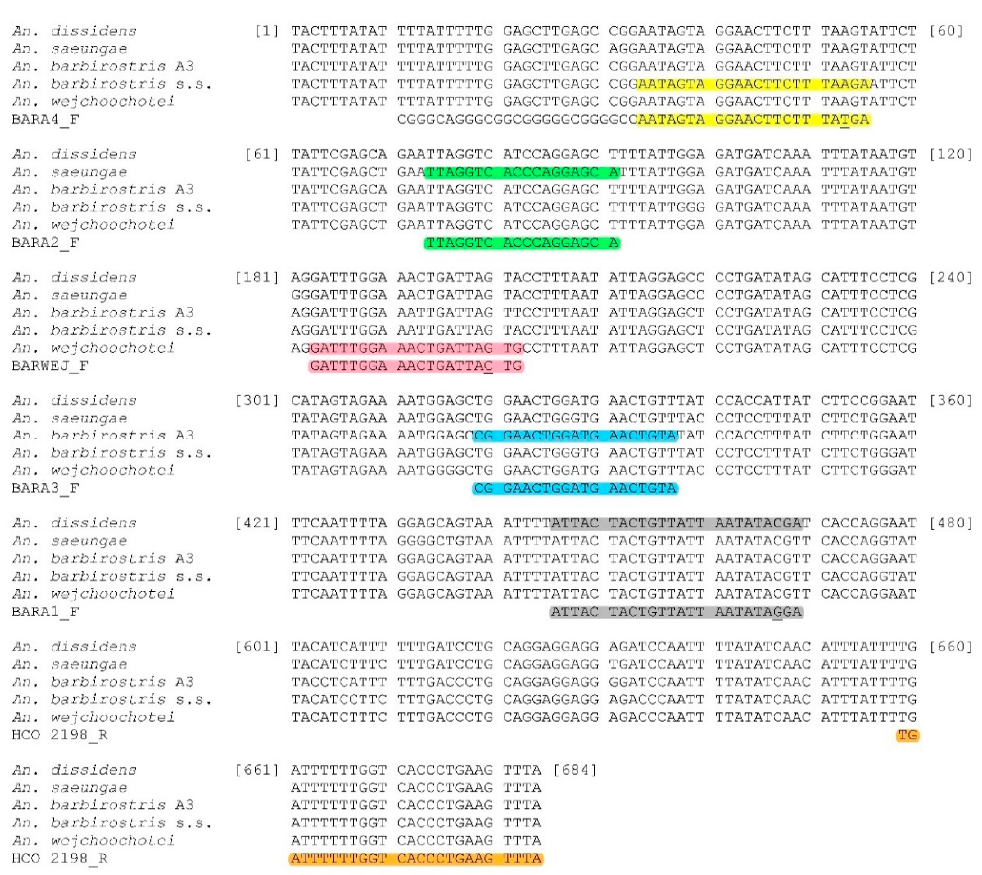
Figure 2. Alignment of COI sequences of five species of the Barbirostris Complex. The primer selection sites are highlighted in colors.